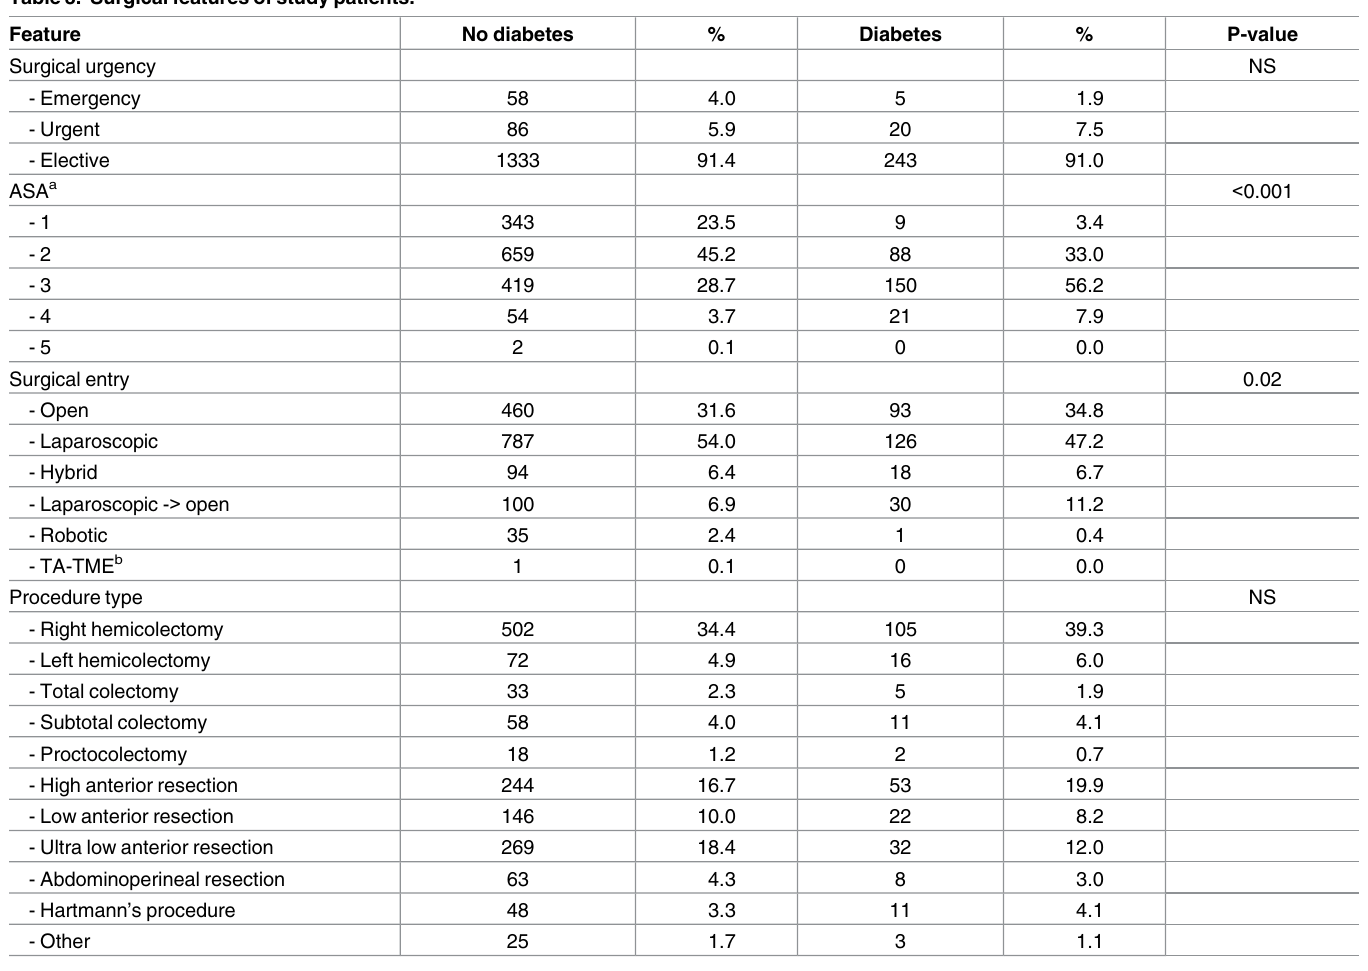
Table 3. Surgical featuresof study